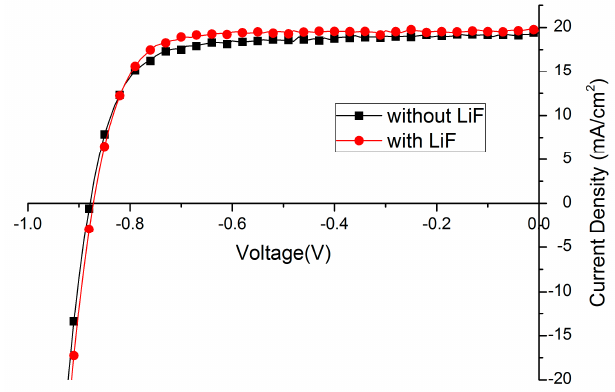
Figure 5. Effect of lithium fluoride (LiF) layer on Current density -Voltage (J–V) curve. Table 3. Effect of lithium fluoride (LiF) layer on solar cell performance. Table 3. Effect of lithium fluoride (LiF) layer on solar cell